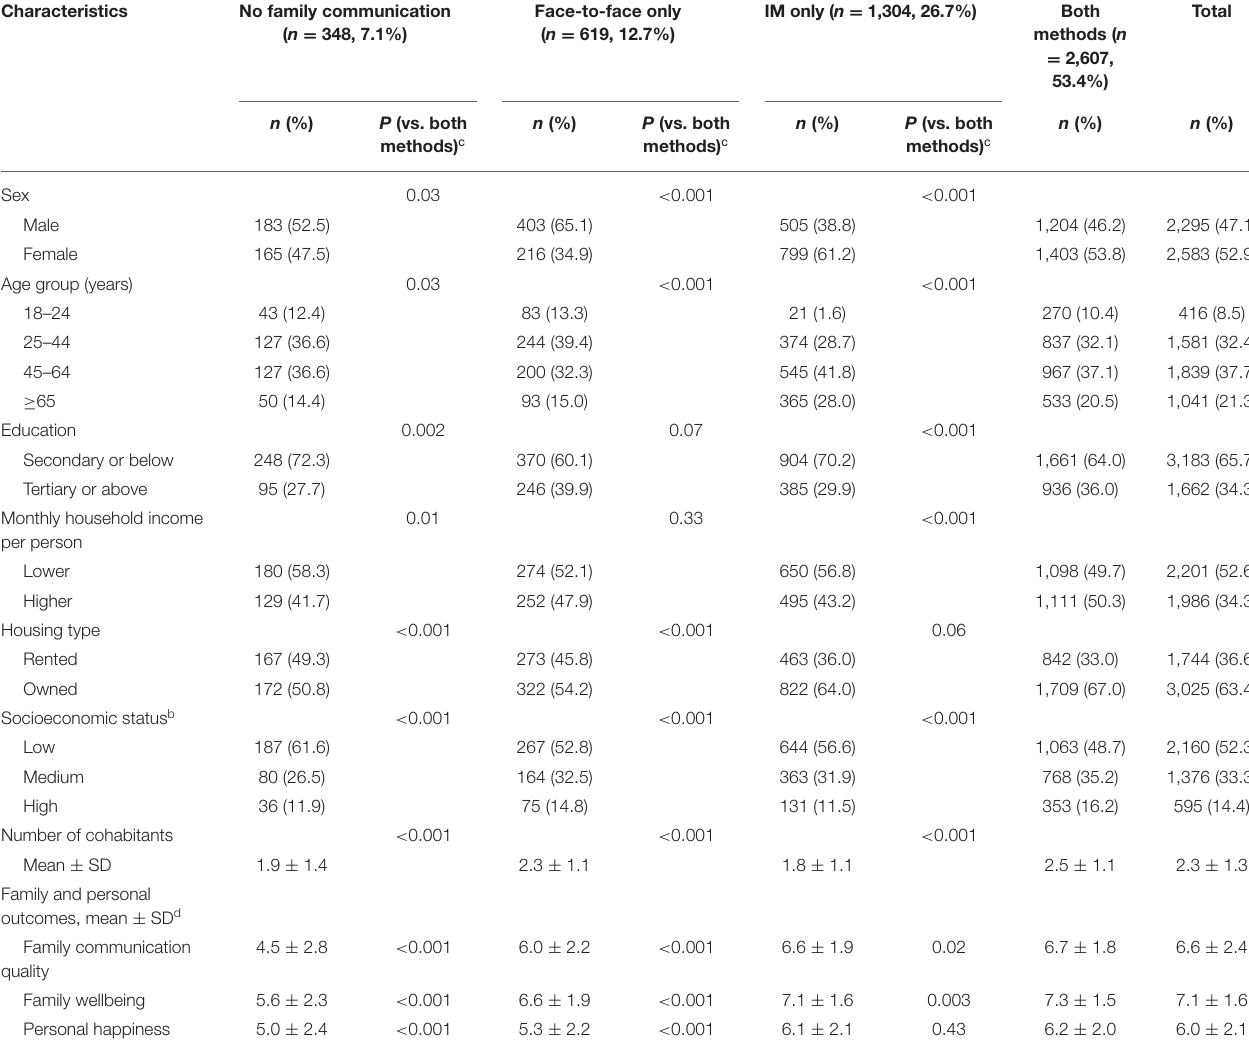
TABLE 1 | Weighted characteristics and family and personal outcomes by communication methods a .